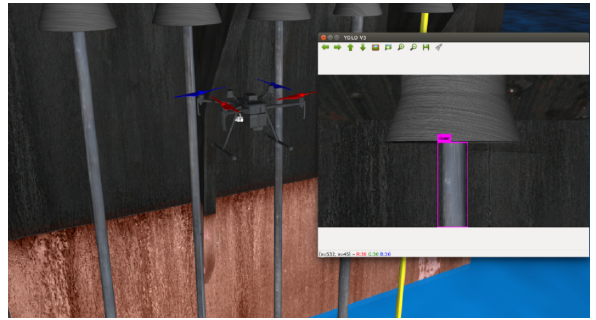
Figure 9. Riser detection at Gazebo simulation using YOLOv3.